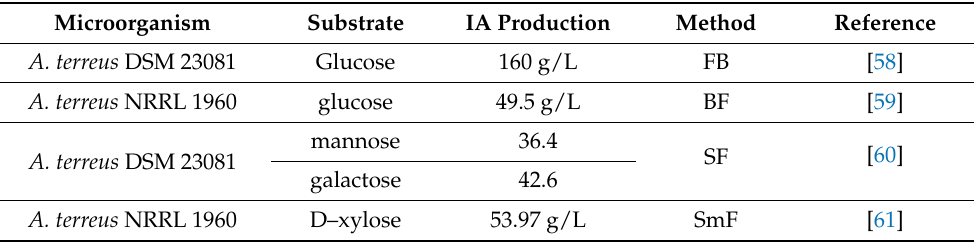
Table 1. Mono- and polysaccharides based IA